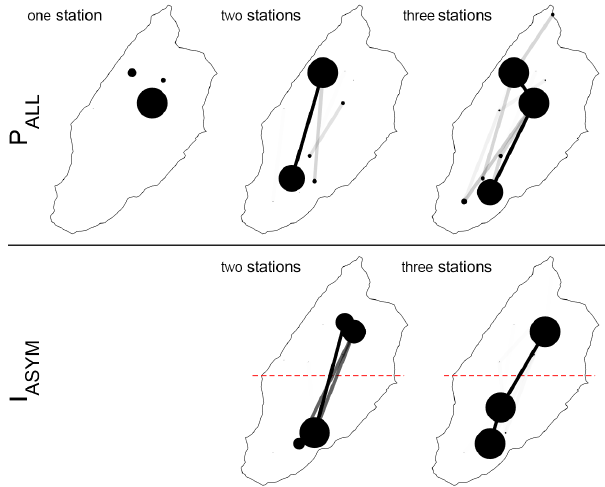
Figure 11. Sensitivity test over the best network from one to three stations, evaluated by removing from one to three events over the 23 events (2047 combinations) for the P ALL and I ASYM . The re- sult is presented graphically. Larger dots and wider links represent configurations that are found more frequently than others over the different simulations. The red dashed line splits the catchments into two parts of equal